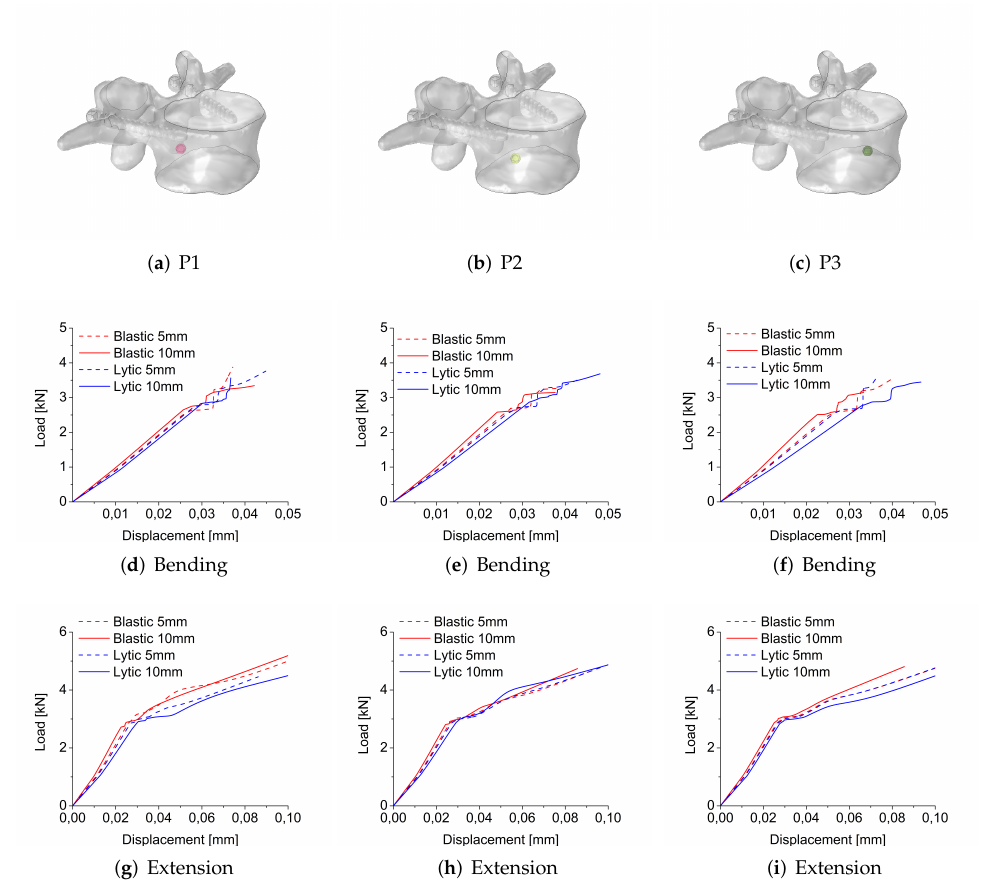
Figure 10. For each position (P1 ( a ); P2 ( b ); P3 ( c )), the load-displacement curves obtained for osteoblastic and osteolytic metastases with radii of 5 and 10 mm in bending ( d – f ) and extension- loading ( g – i ) conditions using the stress-based failure criterion are